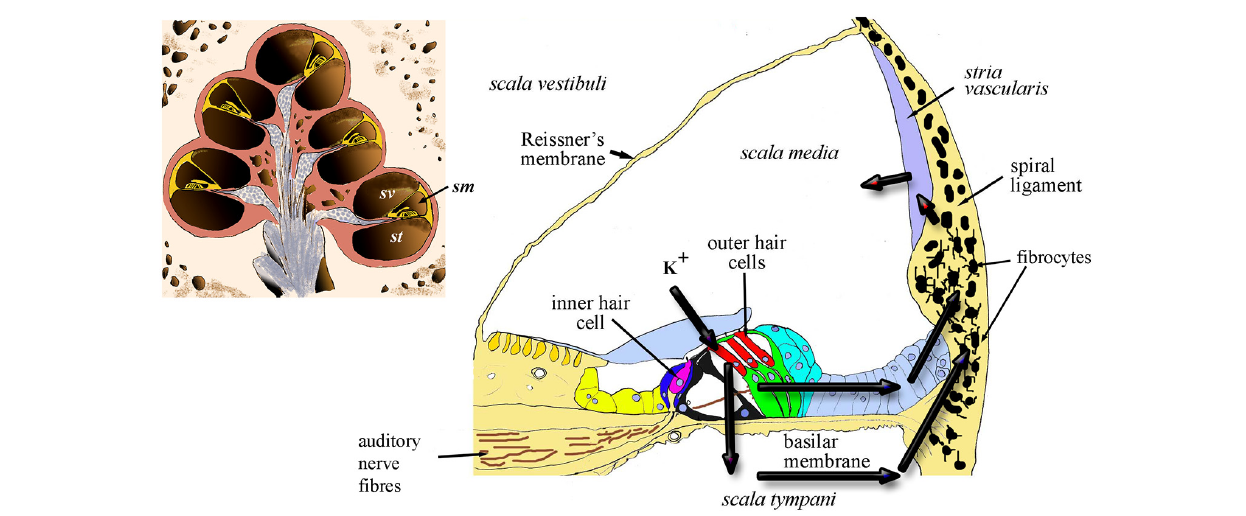
FIGURE 1 | Diagrammatic representation of the cochlea in section (inset) showing the chambers of the spiral and the location of scala media (sm) scala vestibuli (sv) and scala tympani (st). The main panel shows a cross-section of the sm and the arrows indicate the two probable routes of recycling potassium through the organ of Corti, perilymph and lateral wall, including the